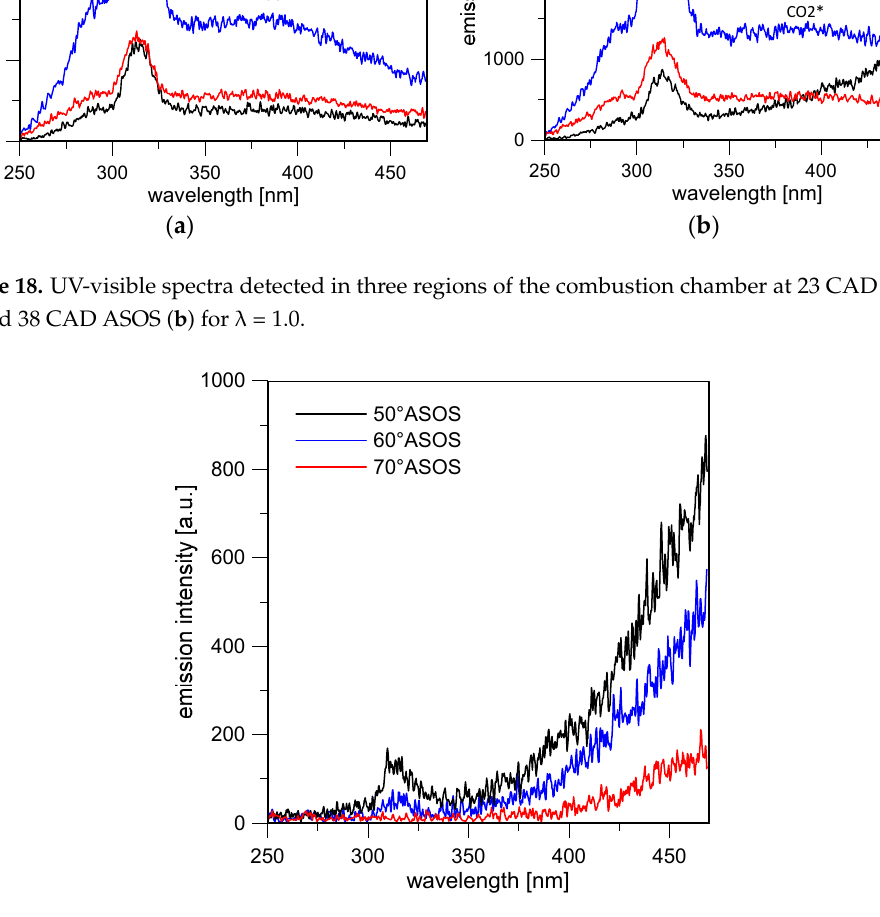
Figure 19. UV-visible spectra detected near the intake valves in the late combustion phase for λ = 1.0.